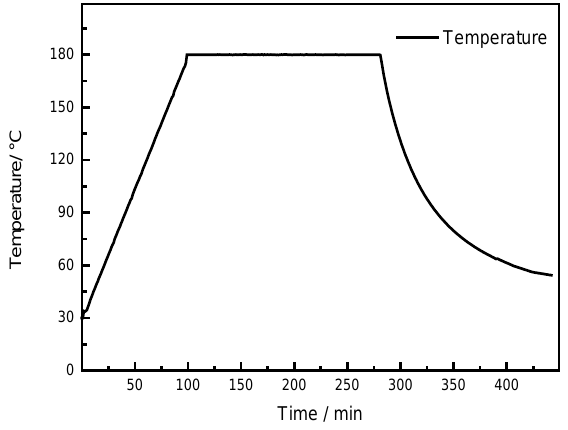
Figure 2. Non-isothermal temperature process curve.